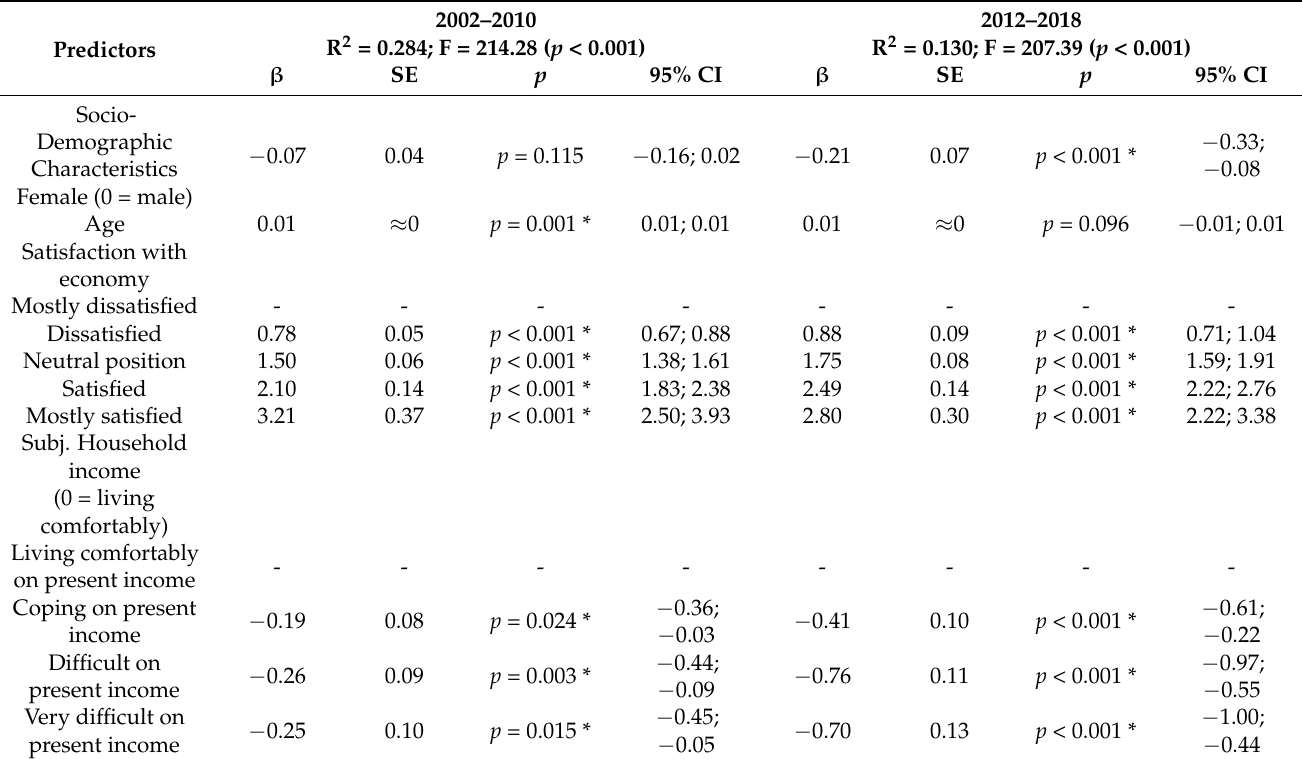
Table 3. Model 2—current economic situation.